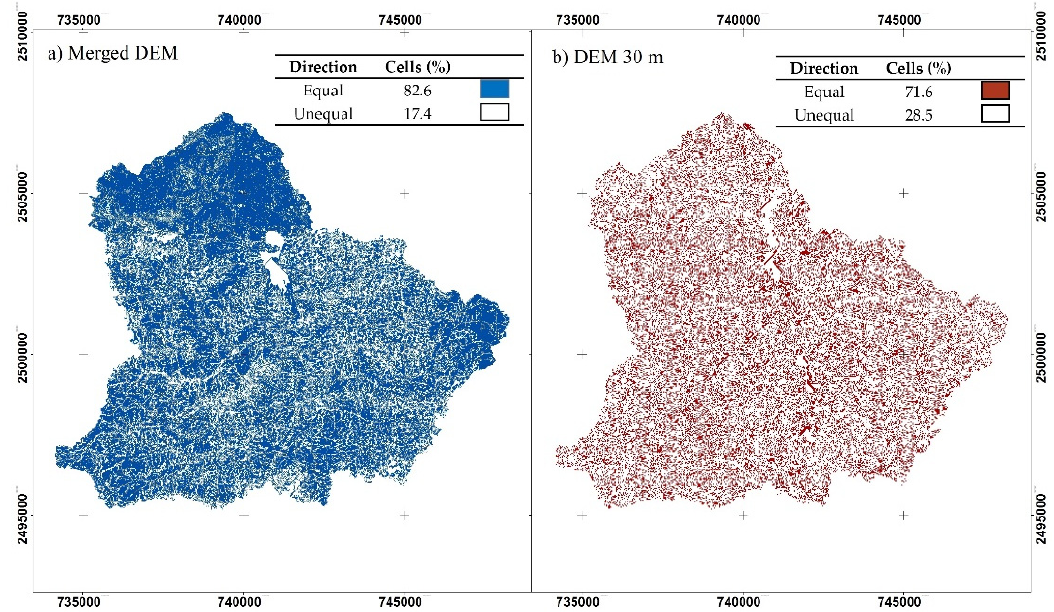
Figure 4. Differences in flow directions: ( a ) merged DEM and ( b ) DEM 30 m.